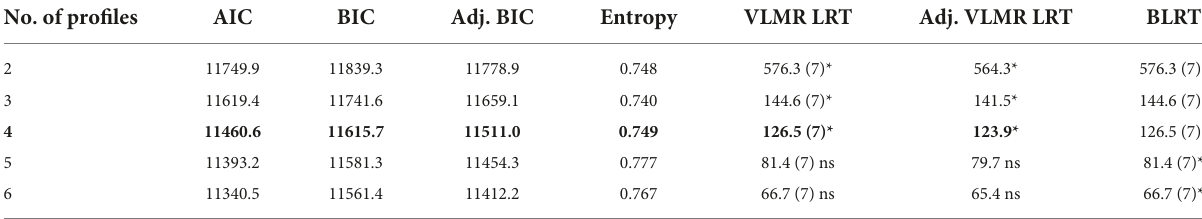
TABLE 3 Comparison of fit indices for latent class analysis models with 2–6 classes for home learning environment (HLE)